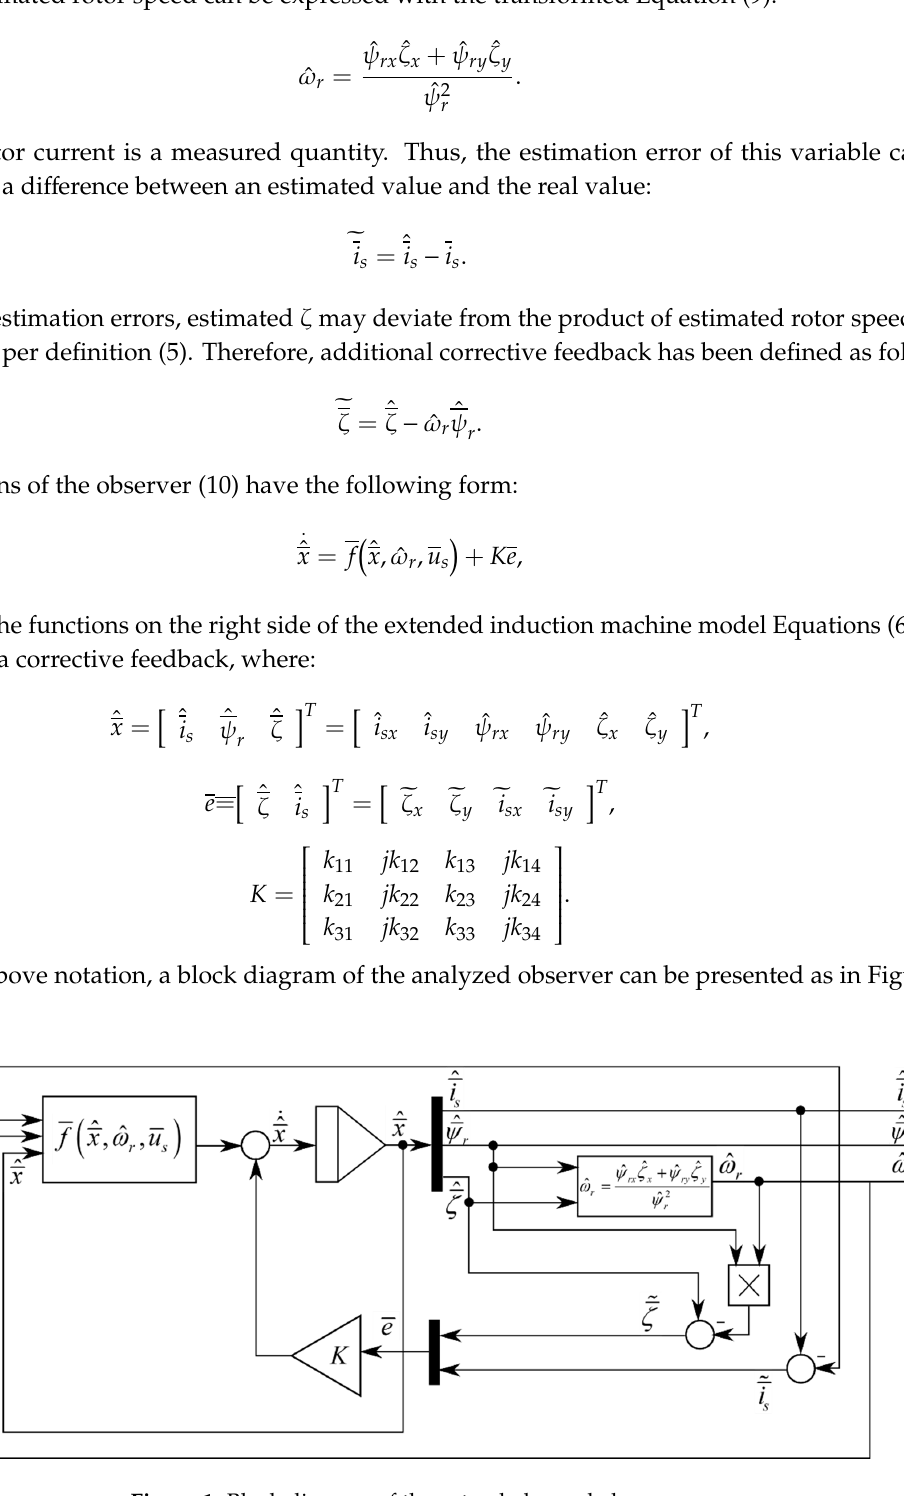
Figure 1. Block diagram of the extended speed observer.